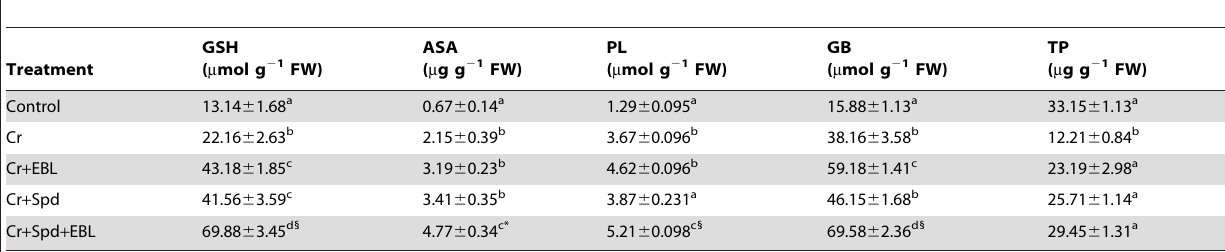
Table 2. Effect of EBL and/or Spd on endogenous profiles of antioxidants in radish seedlings under Cr-stress.